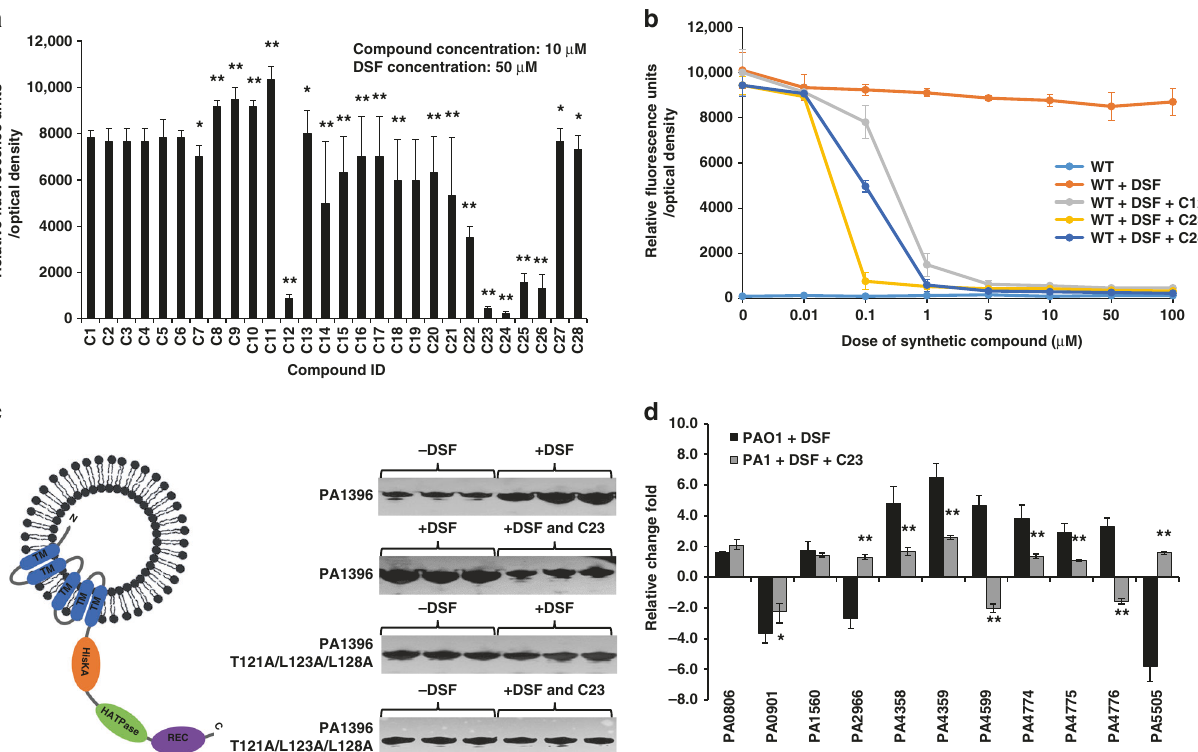
Fig. 3 Diffusible signal factor (DSF) analogs inhibit PA1396 activity. a The effects of analogs (at 10 μ M) on activation of the pmr-gfp transcriptional fusion by DSF (50 μ M) was measured as GFP fl uorescence. Data shown are means of three replicates and error bars indicate the standard deviations. The asterisks indicate those analogs for which the level of gfp expression was signi fi cantly different from that of DSF alone ( p < 0.01, Student's t- test). b Dose – response relationships of the effects of selected analogs on DSF activation of the pmr-gfp transcriptional fusion in wild-type P. aeruginosa . DSF was present at 50 μ M. The analogs tested were C12 ( cis- 13-methyl tetradecenoic acid), C23 ( cis- 11-methyl dodecenoyl methyl sulfonamide), and C24 ( cis- 11-methyl dodecenoyl cyclopropanamide). Values are the average of three technical repeats (mean± standard deviation). The observed values were signi fi cantly different from the appropriate wild type in all cases ( p < 0.05, ANOVA). c PA1396 auto-phosphorylation in response to DSF and analogs. Left panel: Schematic representation of the orientation of PA1396 in the liposome assay. Domain abbreviations are: HisKA: His Kinase A (phosphoacceptor) domain; HATPase_c: Histidine kinase-like ATPases; REC: CheY-homologous receiver domain. Blue bars indicate different transmembrane helices. Right panel: PA1396 auto- phosphorylates in the liposome (lanes 1 – 3; which are triplicate assays), but increased phosphorylation is seen in response to 10 μ M DSF (lanes 4 – 6); PA1396 phosphorylation in response to 10 μ M DSF (lanes 1 – 3) is abrogated in the presence of C23 (lanes 4 – 6); PA1396 (T121A/L123A/L128A) variant protein auto-phosphorylates but does not response to the presence of DSF and/or C23. d Differential expression of selected genes implicated in virulence, antibiotic resistance, or bio fi lm formation in the presence DSF, C23, and DSF in combination with C23. The qRT – PCR data were normalized to proC are presented as the fold change with respect to the wild type for each gene. Data (means ± standard deviation) are from one representative experiment ( n